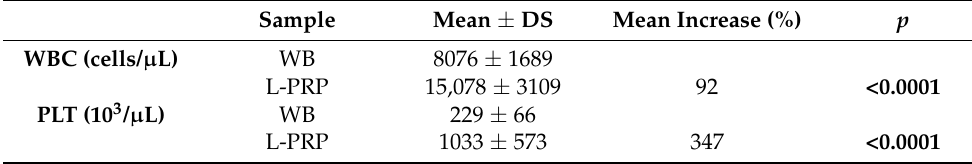
Table 3. Mean platelet and leukocyte mean concentration in WB and L-PRP.